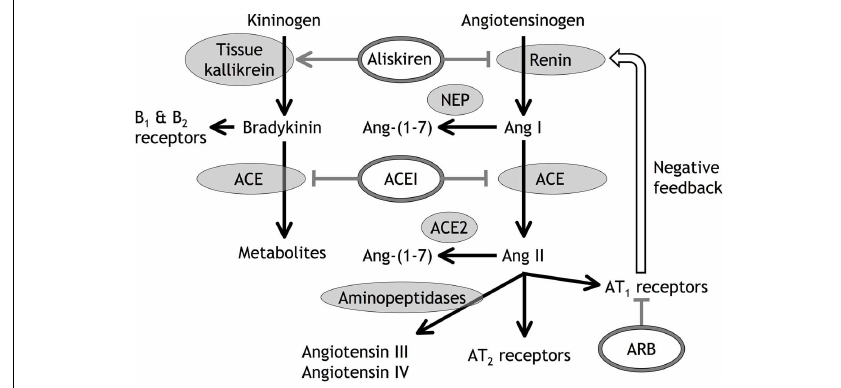
FIGURE 1 | Diagrammatic representation of angiotensin (Ang) and bradykinin peptide formation and metabolism, with the sites of action of angiotensin converting enzyme (ACE) inhibitors (ACEI), angiotensin type 1 (AT 1 ) receptor blockers (ARB), and the renin inhibitor aliskiren . In addition to inhibiting renin, aliskiren increases tissue kallikrein activity and bradykinin levels that may act on bradykinin type 1 (B 1 ) and type 2 (B 2 ) receptors (55). Neutral endopeptidase (NEP) converts Ang I to Ang-(1-7), ACE2 converts Ang II to Ang-(1-7), and aminopeptidases convert Ang II to Ang III and Ang